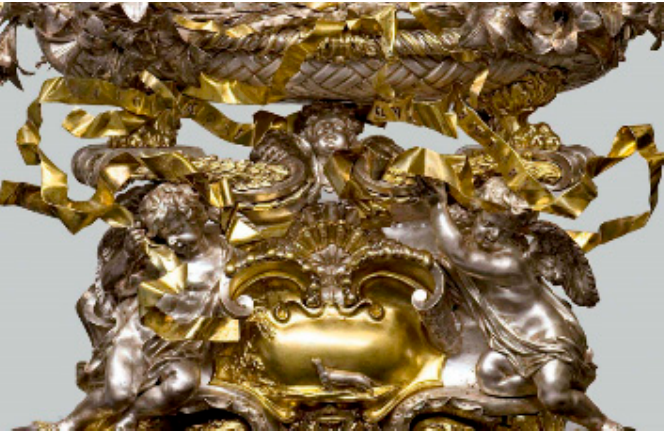
Figure 13. Massimo Soldani Benzi and grand ducal Galleria , Reliquary of St. Kazimierz Jagiello´nczyk, 1687–1688 (detail). Museo delle Cappelle Medicee, Church of San Lorenzo, Florence. Image in the public domain.